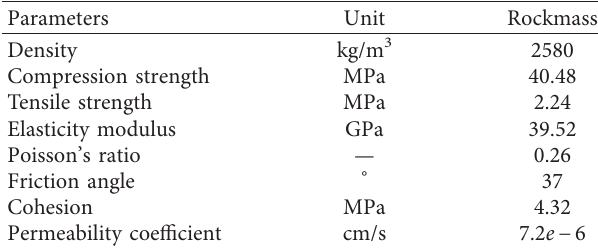
Table 1: Parameters of geotechnical